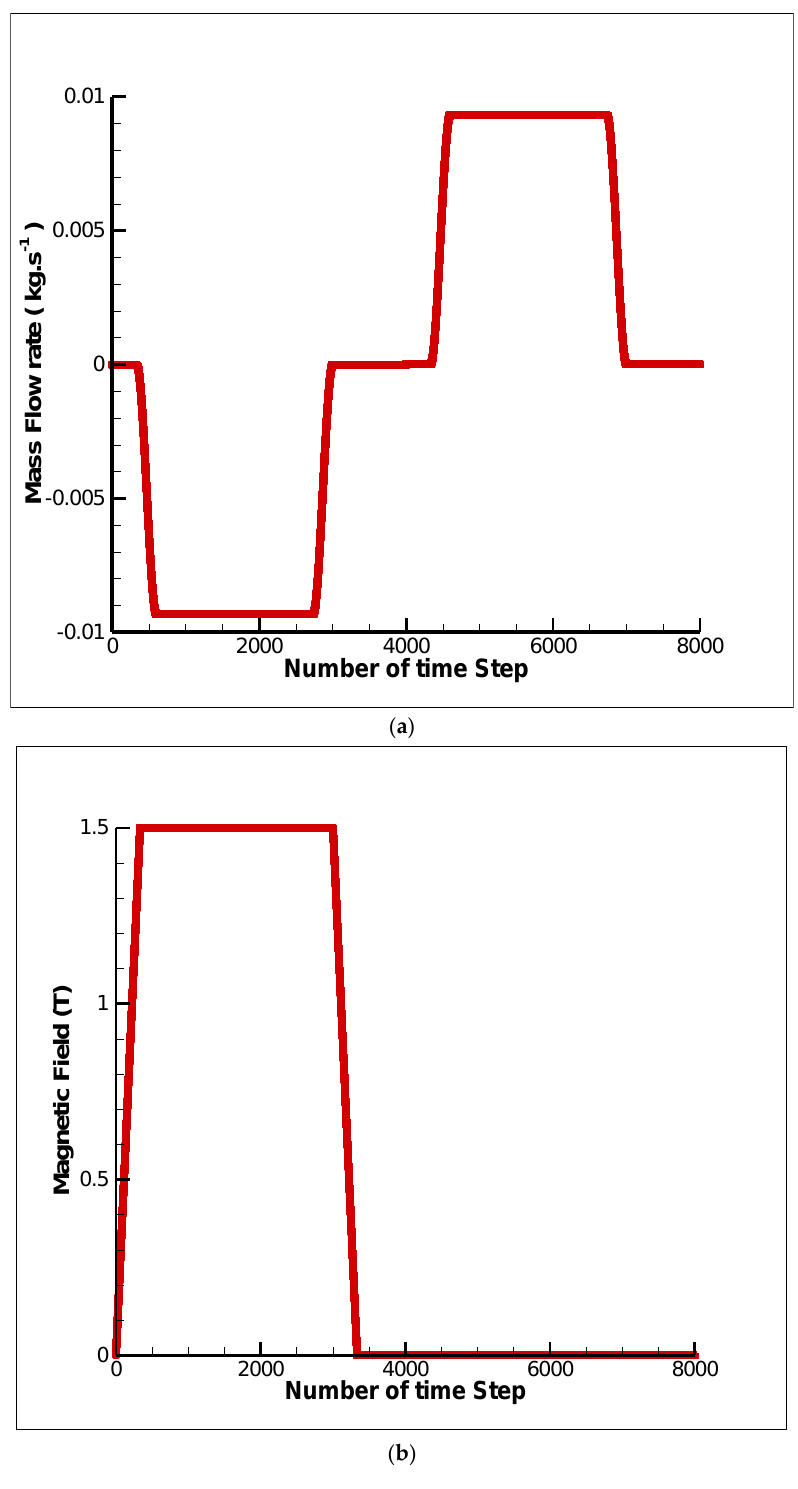
Figure 7. ( a ) mass flow rate and ( b ) magnetic field variations for each bed during a cycle in a rotary device.